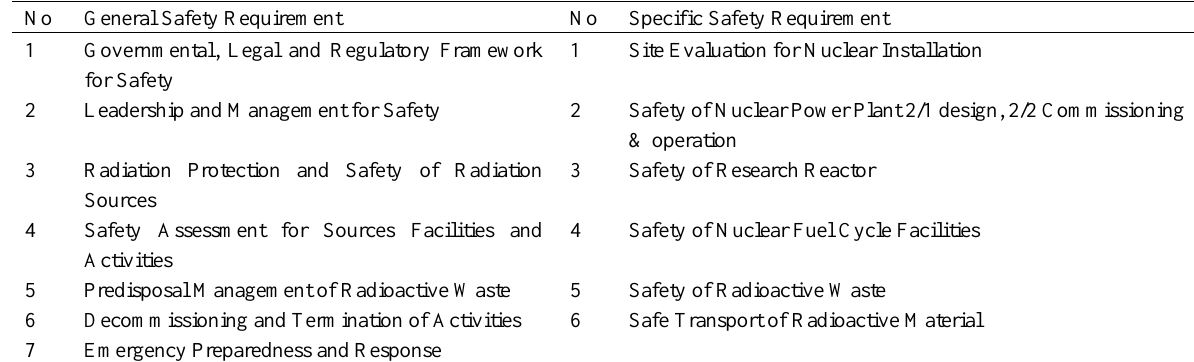
Table 2: Safety Fundamentals Fundamental Safety